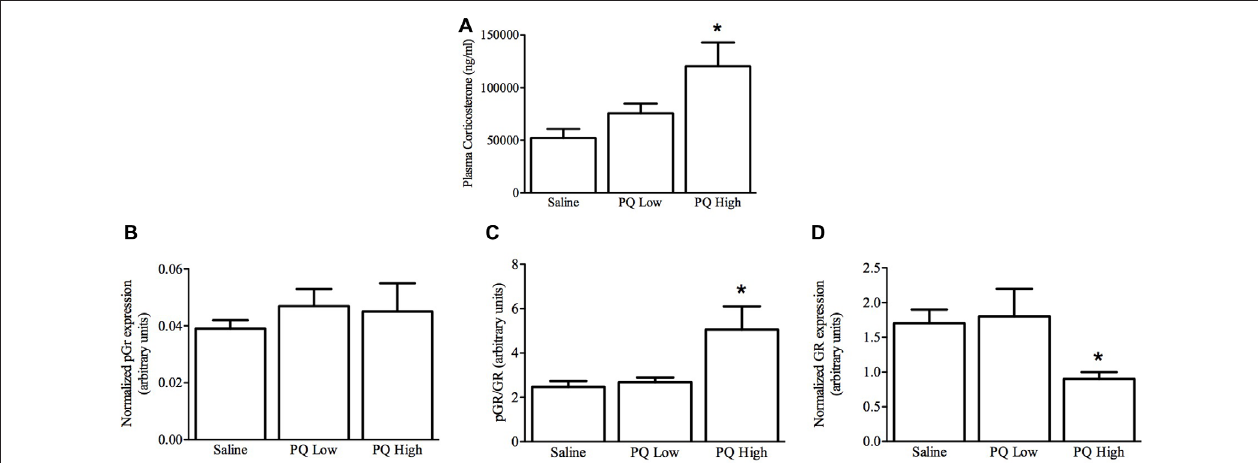
FIGURE 5 | Dose-dependent effects of short term paraquat administration on plasma corticosterone and hippocampal glucocorticoid receptor (GR) levels. As shown in (A) , the higher paraquat dose (PQ High; 10 mg/kg) relative to the lower dose (PQ Low; 1 mg/kg) significantly increased plasma corticosterone levels. At the same time, paraquat did not increase levels of the active form of GR (pGR; B) , but the higher toxicant dose did increase levels of pGR relative to GR (C) . However, given that the higher paraquat dose decreased levels of total GR (D) within the hippocampus, pGR levels were unaltered by the toxicant. ∗ p < 0.05, relative to saline and low dose paraquat treated mice.